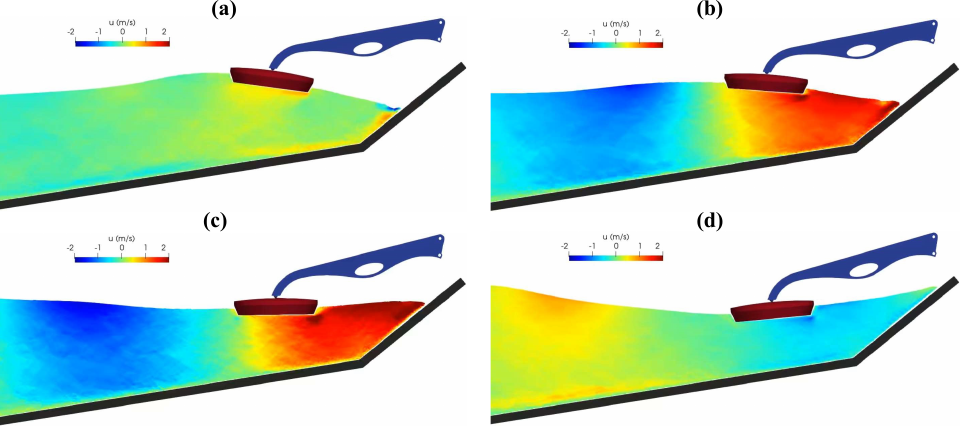
Figure 8. Snapshots of the velocity field in the vicinity of the WEHC device for H = 2 m and T = 7 s with impermeable and straight breakwater at ( a ) t = 100 s, ( b ) t = 102 s, ( c ) t = 104 s and ( d ) t = 107